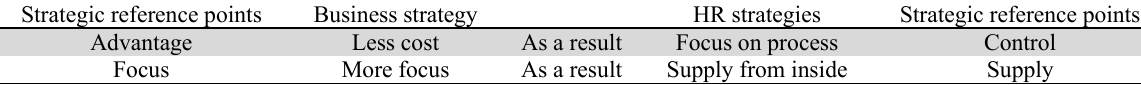
Basis of alignment in strategies based on low cost and high separation Strategic reference